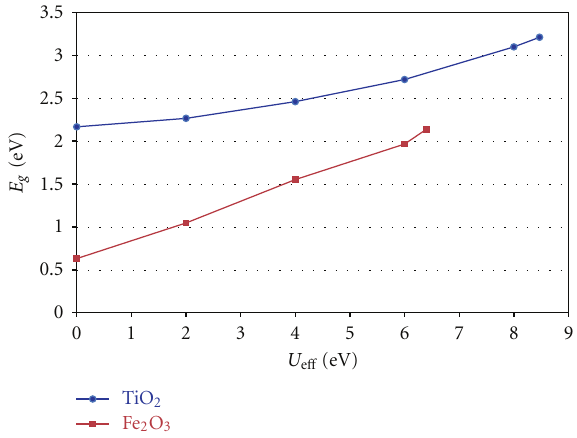
Figure 2: Relationship between the e ff ective Hubbard parameter ( U e ff ) and the band gap ( E g ) for anatase TiO 2 and Fe 2 O 3 . electrons, capable of producing a more optimal band